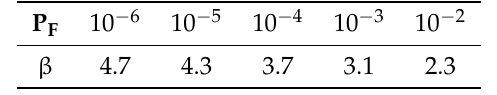
Table 1. Relation between the probability of failure P F and the resulting reliability index β .